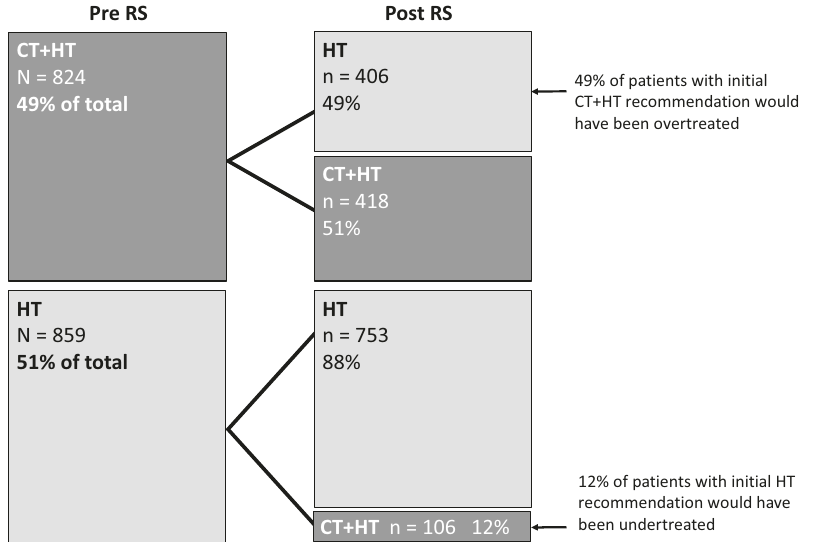
Fig. 1 Changes in treatment recommendations before and after availability of the Recurrence Score result. Rates of hormone therapy alone (HT) or chemo-endocrine therapy (CT + HT) recommendations before testing (Pre RS) and changes in recommendations based on the test resutls (Post RS).